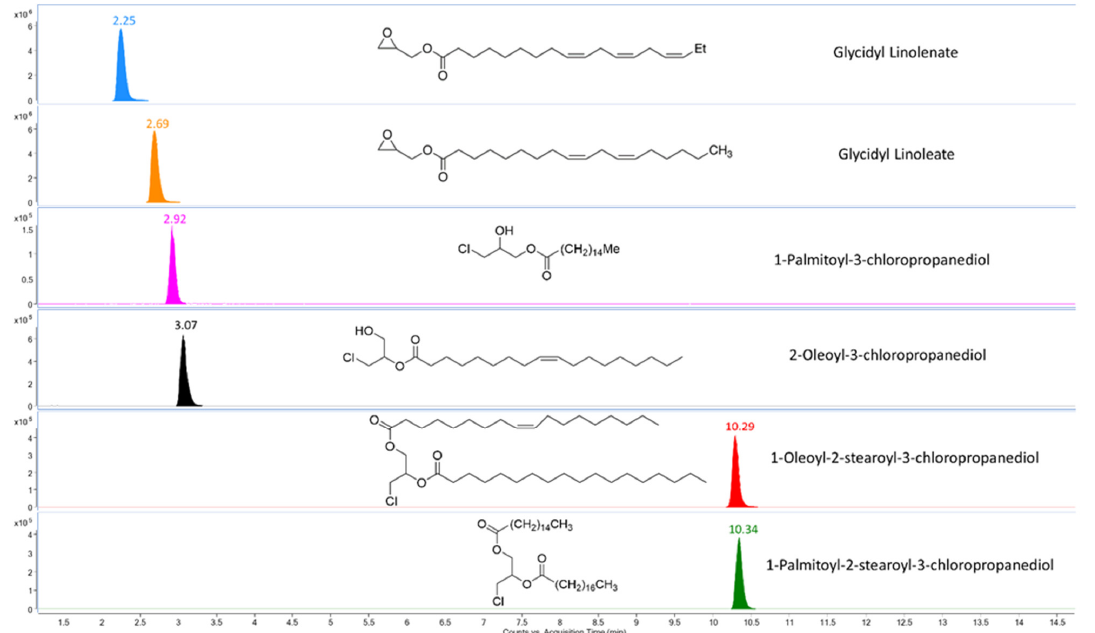
Figure 1. Extracted ion chromatograms for the mixed standard of glycidyl esters (GEs) and 3-monochloropropanediol esters (MCPDEs) in the glycerin matrix. Table 1. Average response for protonated and sodium adducts of GEs and MCPDEs in the mixed standard. Compound Exact Mass (M+H) (M+Na)